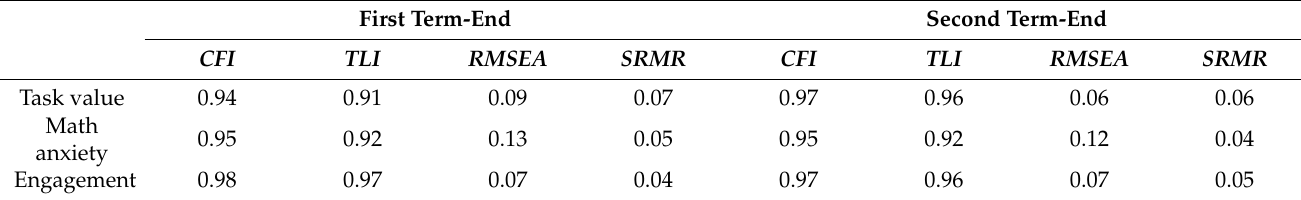
Table 1. Results of confirmatory factor